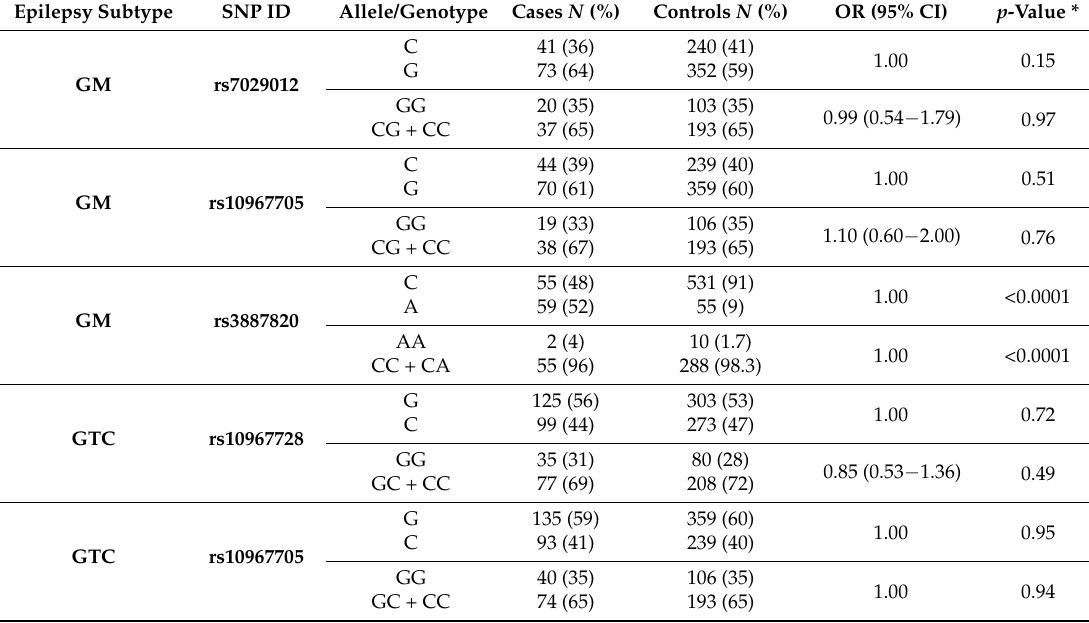
Table 3. Distribution of potassium channel related SNPs in the 172 generalized epileptic patients and 299